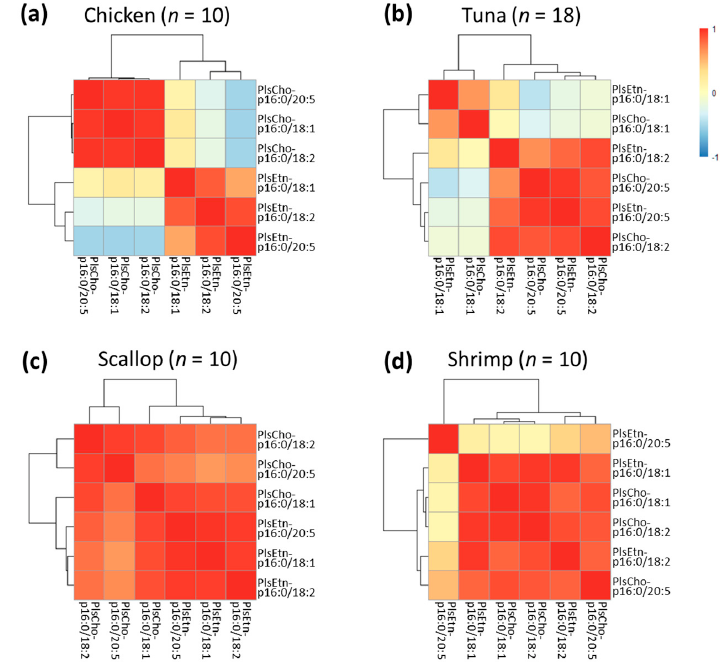
Figure 6. Correlation of plasmalogen species in chicken ( a ), tuna ( b ), scallop ( c ), and shrimp ( d ), calculated as Pearson coefficients. Variables with a high positive correlation to each other were expressed in red, while negative correlations were indicated in blue.